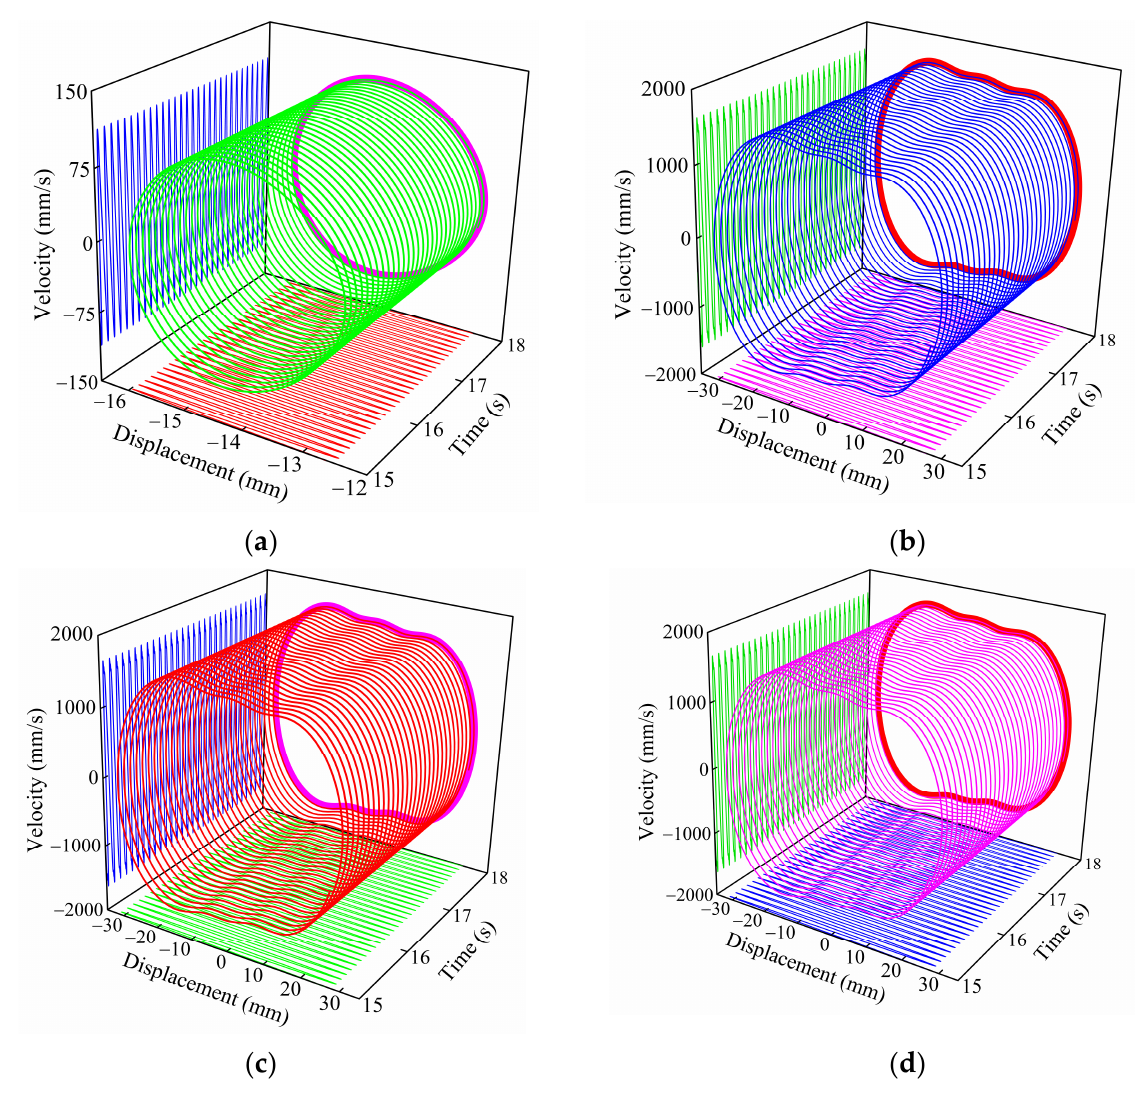
Figure 11. 3D time domain simulation diagram of the system under different u 0 and A : ( a ) u 0 = − 14 mm A = 9 m/s 2 ; ( b ) u 0 = 12 mm A = 9 m/s 2 ; ( c ) u 0 = − 14 mm A = 13 m/s 2 ; ( d ) u 0 = 12 mm A = 13 m/s 2